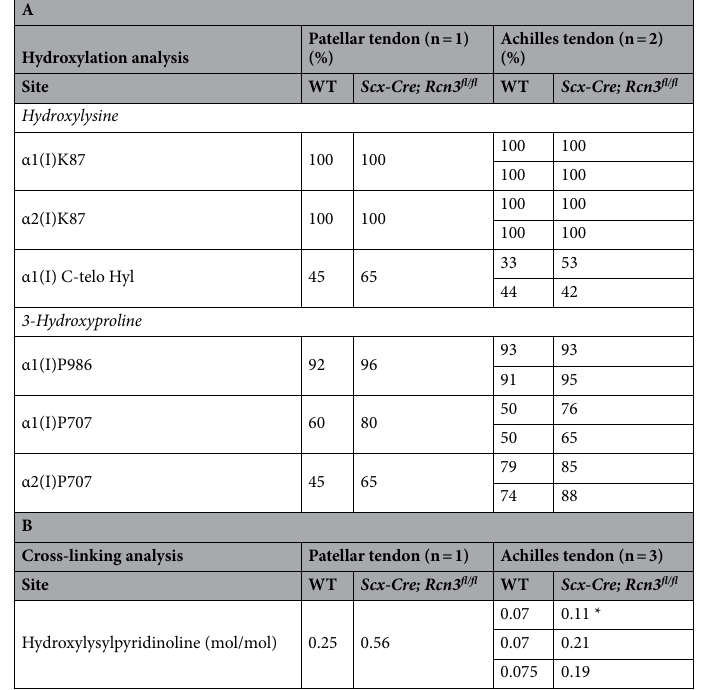
Table 1. Collagen cross-link and mass spectral analysis to investigate the hydroxylation levels (A) of lysine and proline in type 1 collagen (n = 1 for patellar and n = 2 for Achilles tendon) and the collagen cross-linking levels (B) (* indicates P < 0.05 between genotypes, n = 1 for patellar and n = 3 for Achilles tendon) from wild- type mice and Scx-Cre; Rcn3 fl/fl (tendon-specific Rcn3 loss-of-function model) littermates at